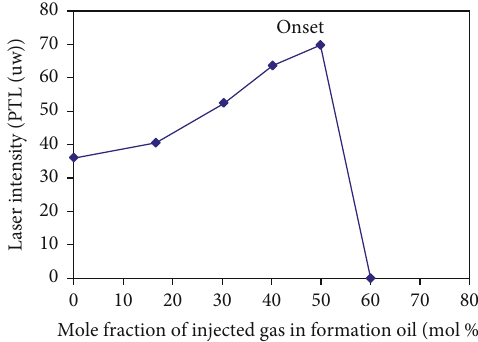
Figure 5: Curves of density of formation oil versus CO